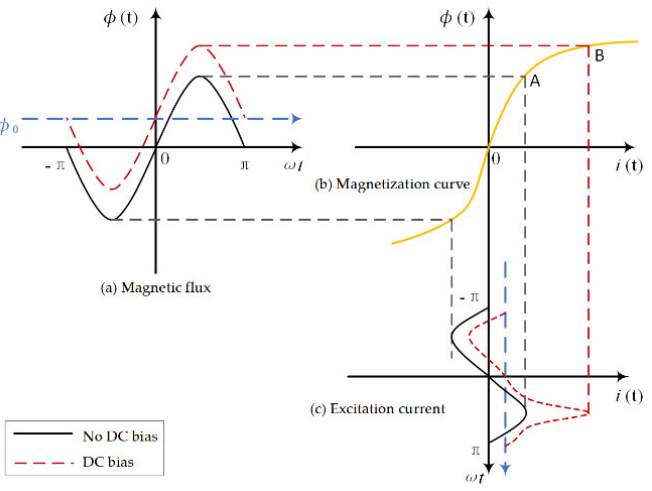
Figure 1. Cause of DC magnetic bias: ( a ) Magnetic flux; ( b ) Magnetization curve; ( c ) Excitation current.